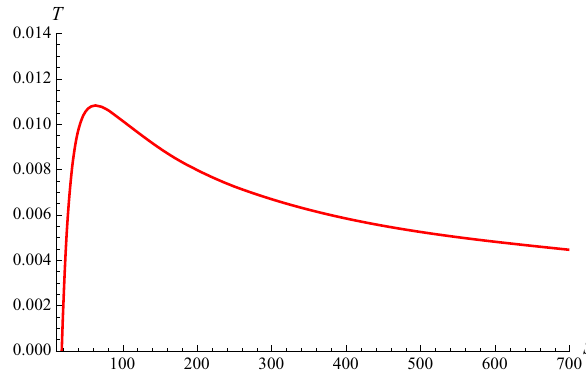
Fig. 4 Plot of the heat capacity with respect to the mass for different b . Left blue curve corresponds to β = 1 and b = 0 . 01. Right red curve corresponds to β = 1 and b = 0 . 5